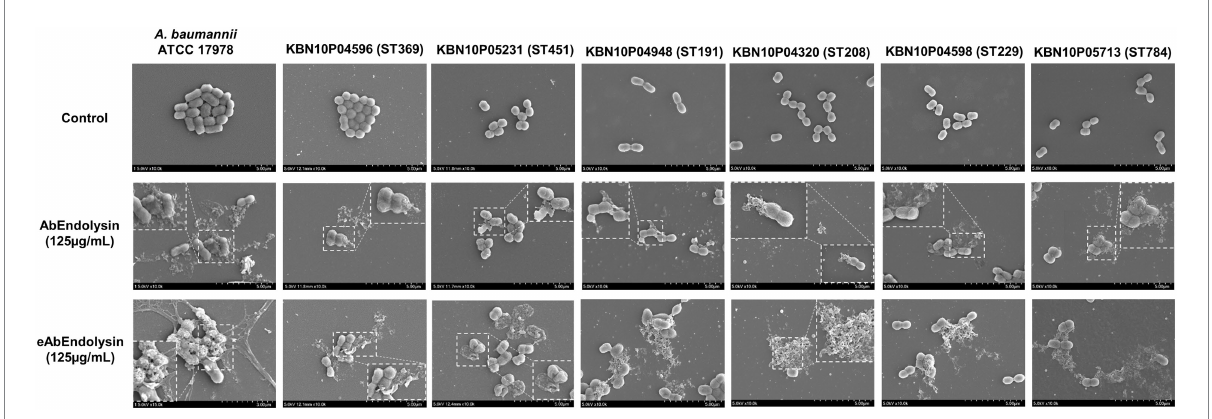
FIGURE 3 In vitro bactericidal effect of eAbEndolysin. Representative scanning electron microscopy (SEM) images of multidrug-resistant A. baumannii ATCC 17978 and clinical isolates (ST191, ST208, ST229, ST369, ST451, and ST784) after incubation with AbEndolysin, eAbEndolysin (125 μ g/ml), and PBS were visualized using a field-emission scanning electron microscope. The scale bar corresponds to 5 μ